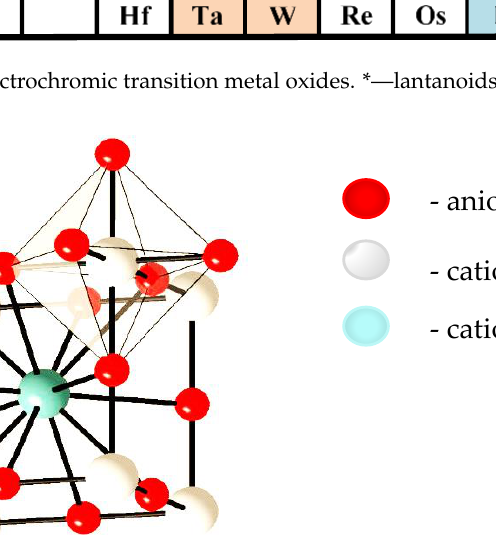
Figure 12. Electrochromic transition metal oxides. * — lantanoids.